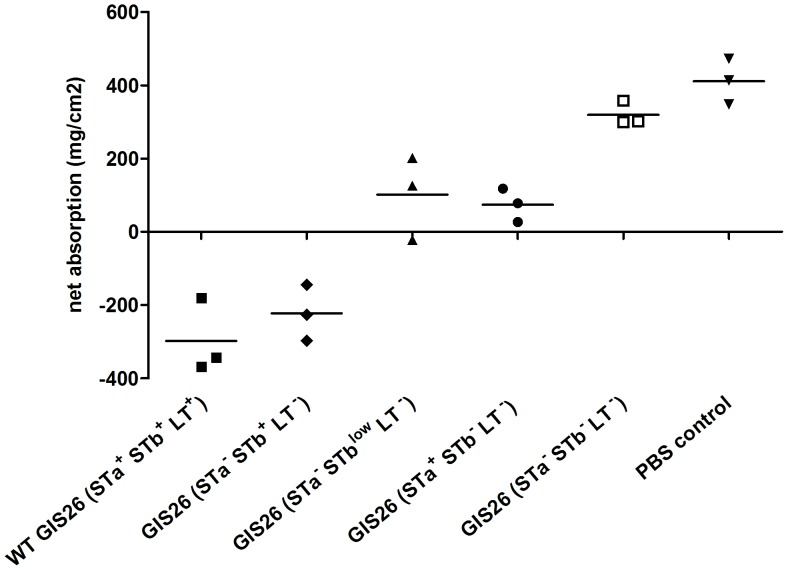
Effect of wild type and mutant GIS26 ETEC strains on net fluid absorption (mg/cm2) in 4 h-infected jejunal segments.Individual data per piglet and the mean from 3 individual experiments are presented.